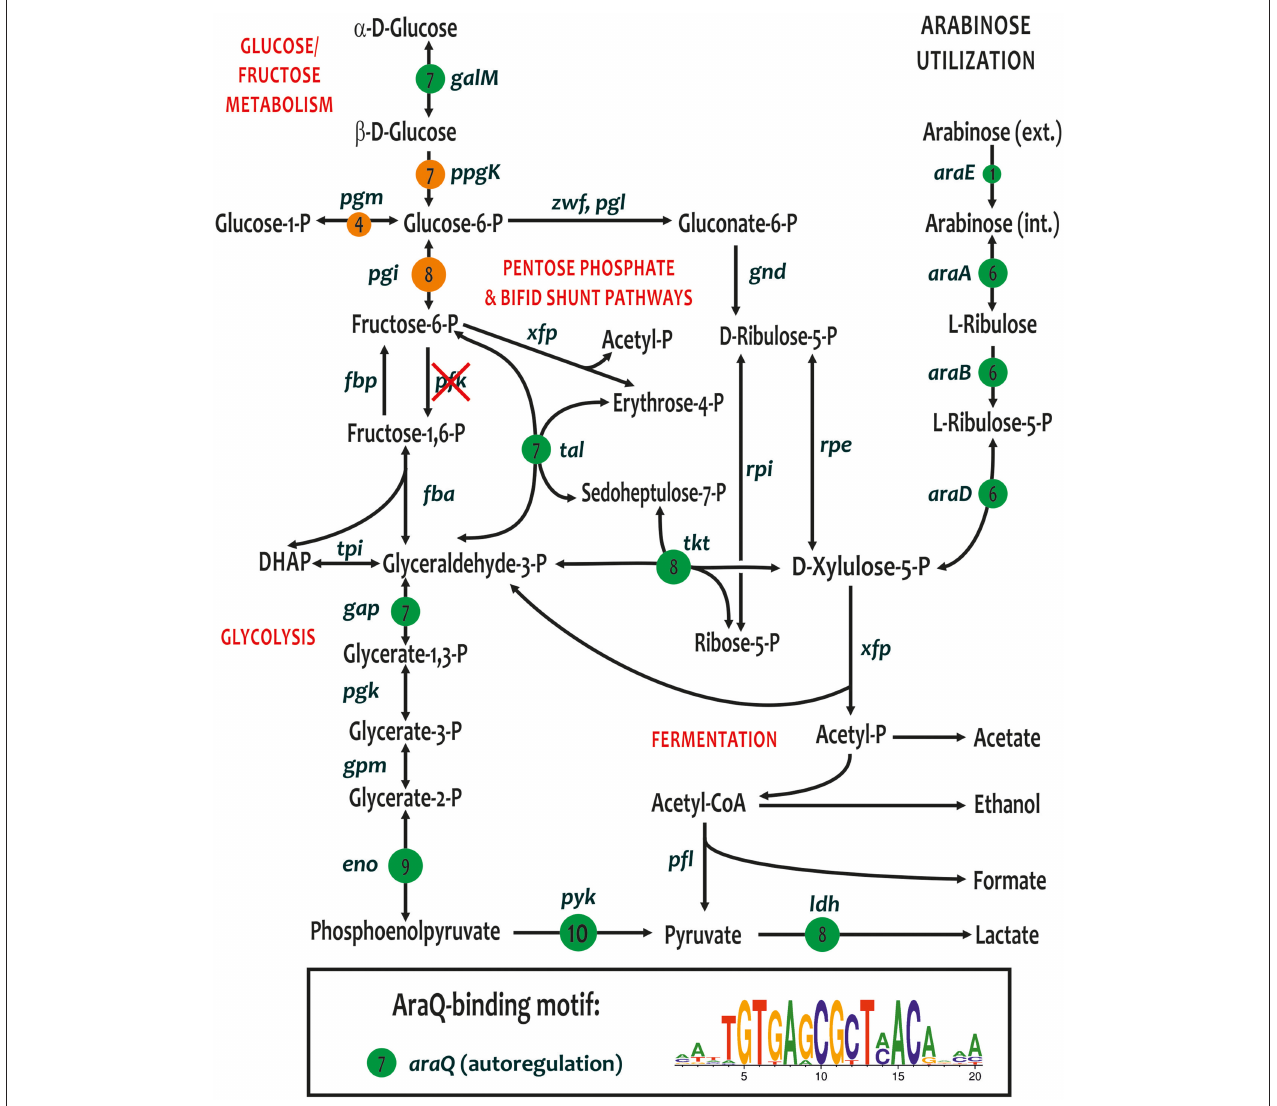
FIGURE 4 | Metabolic context of conserved core of the reconstructed AraQ regulons in the genomes of bifidobacteria. The AraQ-regulated genes are shown by green circles. Numbers in circles show the numbers of genomes where gene is preceded by a candidate AraQ-binding site. Consensus sequence logo for the predicted AraQ-binding sites in 10 Bifidobacterium genomes is shown in a box insert. Additionally, the MalR-regulated genes are shown by orange